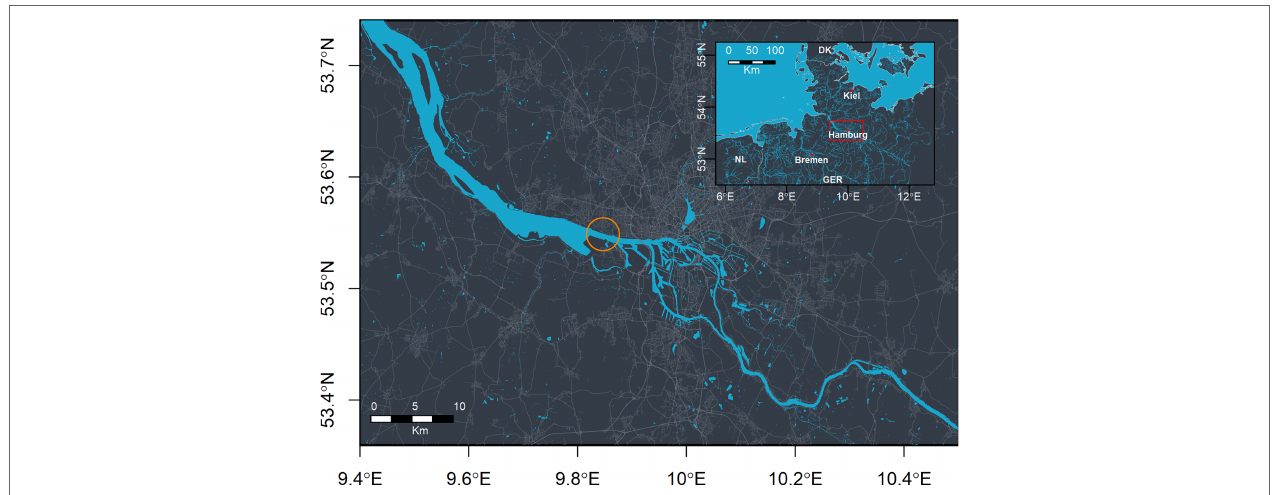
FIGURE 1 | Overview of the study area (top-right corner). The red rectangle marks the area shown in the detailed map. The orange circle marks the position of the acoustic